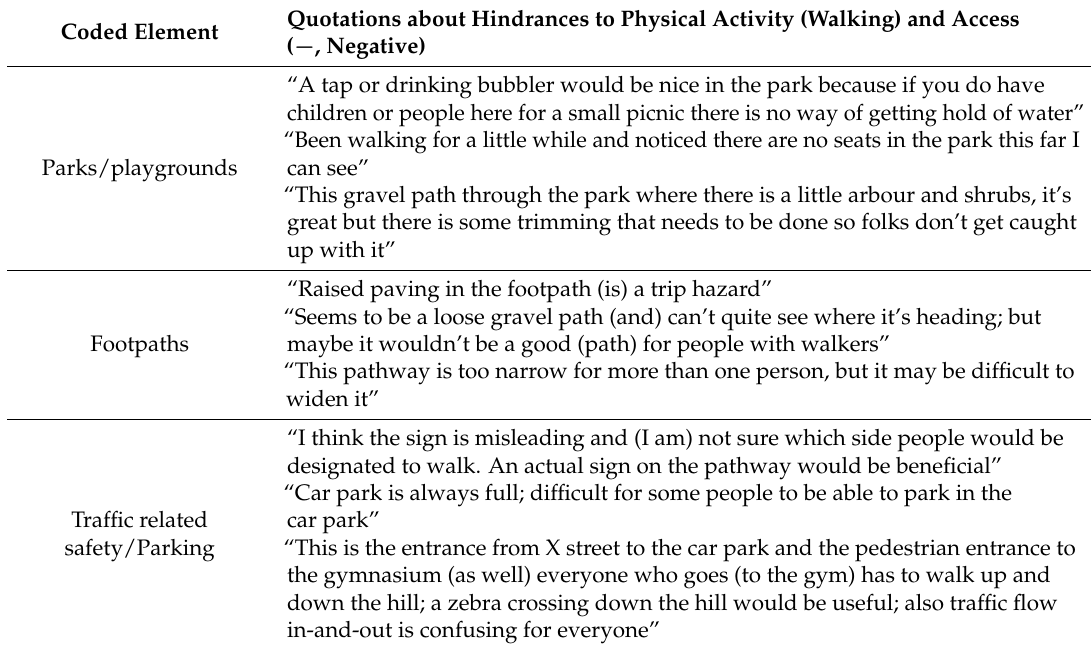
Table 3. Examples of audio narratives (hindrance) to physical activity (walking) and access made by citizen scientists using the Discovery Tool during the Discover sessions, January